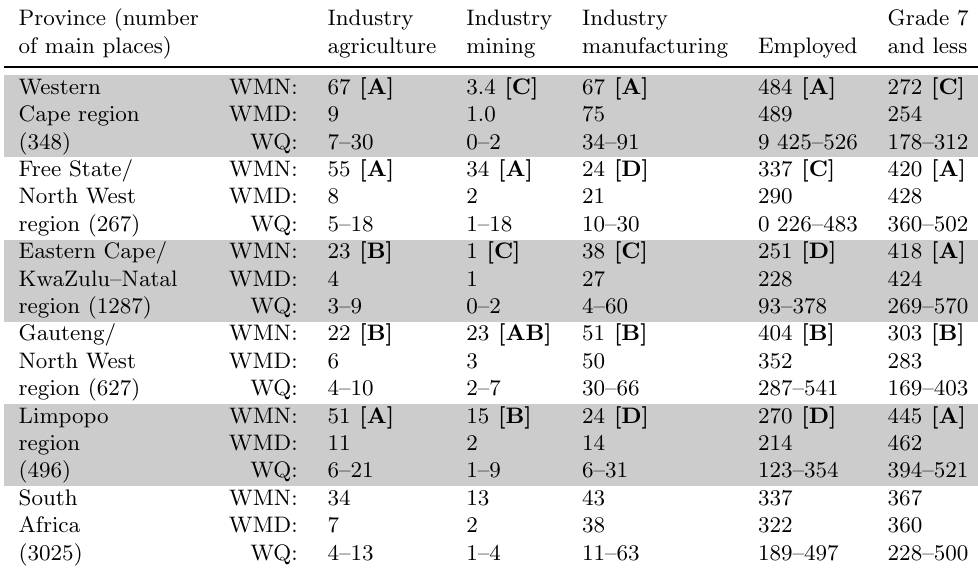
Table 6: Comparing the five intramax regions with respect to industries, employment